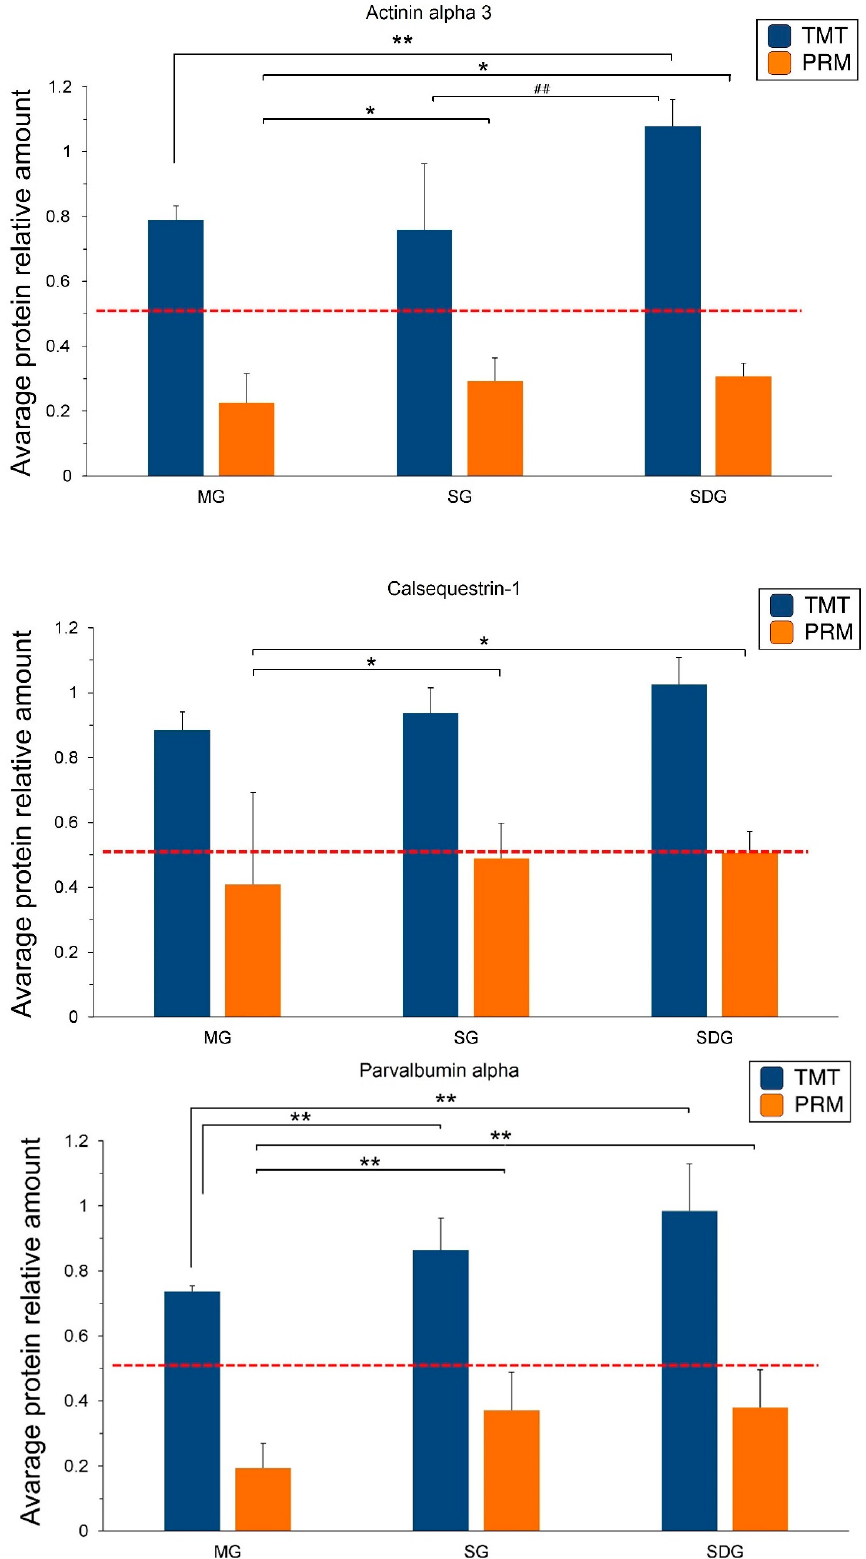
Figure 6. PRM and TMT protein expression quantities of the three candidate proteins, n = 3 samples for each group (3 data points for each bar), each consisting of tissue of 4 rats. Abbreviations: TMT, tandem mass tag; PRM, parallel reaction monitoring. Data are shown as mean ± SD, compared to MG: * p < 0.05, ** p < 0.01; compared to SG: ## p < 0.01 by multiple t-test.